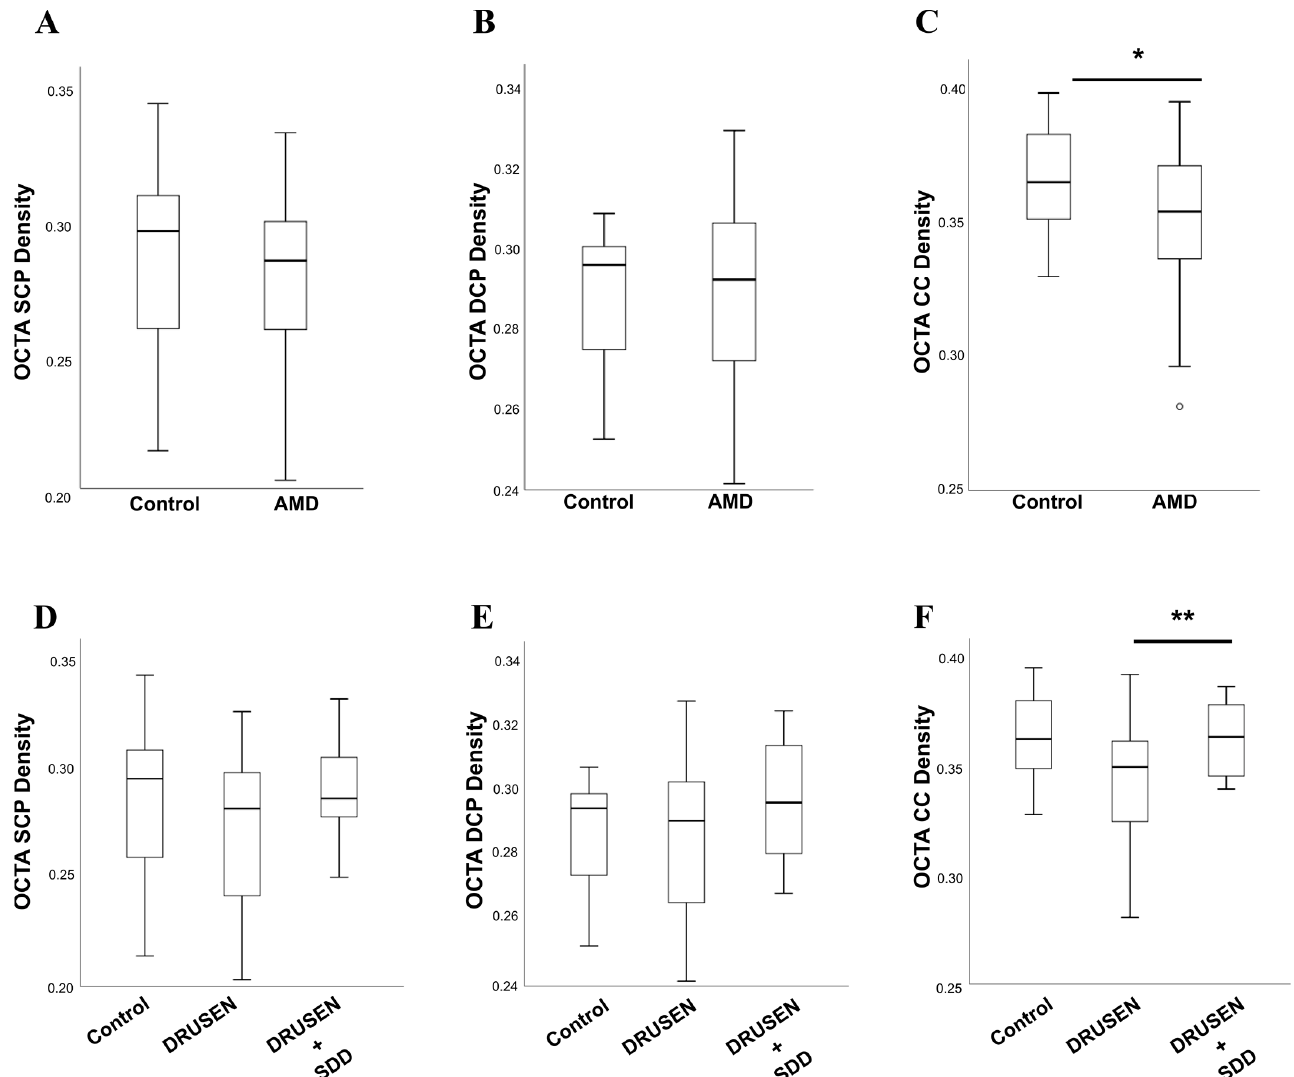
Figure 4. Retinal Capillary Plexus and Choriocapillaris evaluation in intermediate AMD. ( A – C ) Graphical distribution of SCP, DCP and CC flow density obtained by OCTA among control and AMD groups through box plots, respectively. ( D – F ) Box plots showed the distribution of SVP, DVP and CC flow density among the control group and the two sub-groups (i.e., DRUSEN and DRUSEN + SDD) defined among AMD patients, respectively. Box-and whisker plots show median, first and third quartile, the whiskers extend to 1.5 times the interquartile range (IQR) (values exceeding this are plotted as individual points). SCP: Superficial capillary plexus; DCP: Deep capillary plexus; CC: Choriocapillaris; FD: Flow density; DRUSEN: soft or cuticular drusen; DRUSEN + SDD: drusen in association with subretinal drusenoid deposits (* p -value <0.05; ** p -value ≤ 0.01).